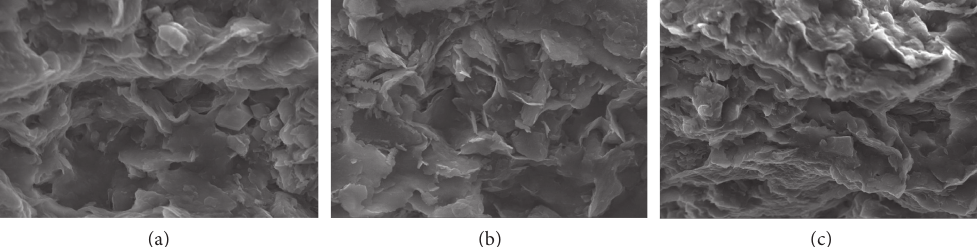
Figure 9: Crack development of sample with different pH value solution after one-time cyclic drying-wetting (5000 times larger). (a) pH � 7, (b) pH � 5, and (c) pH � 3.